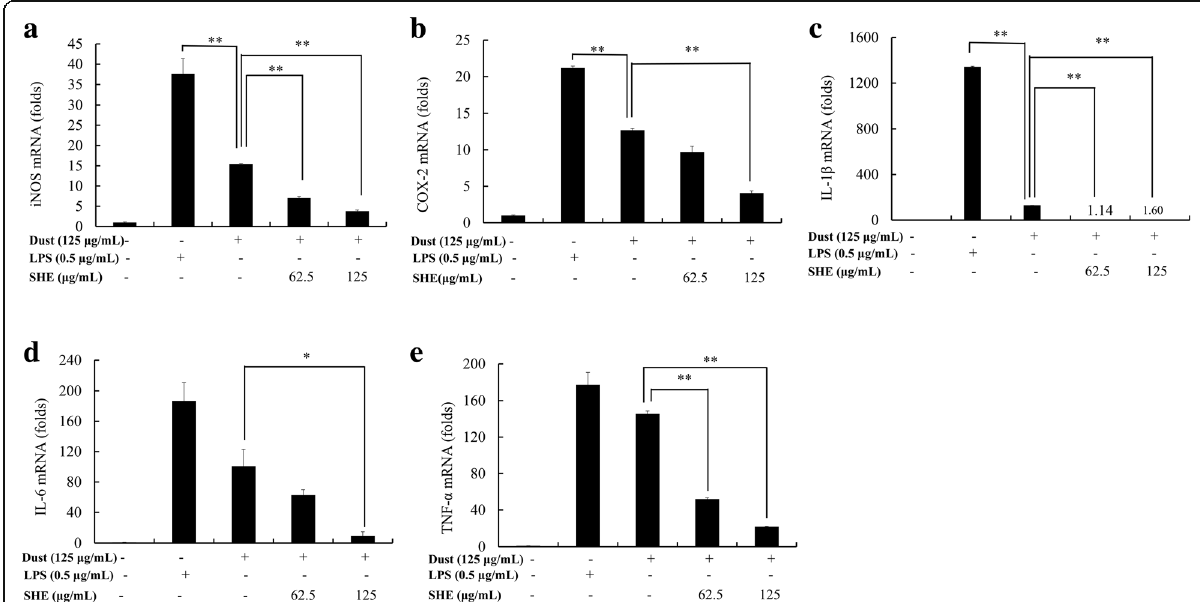
Fig. 4 FD stimulated cells ’ inflammation-associated gene expressions levels: ( a ) iNOS, ( b ) COX-2, ( c ) IL-1 β , ( d ) IL-6, and ( e ) TNF- α . The 2 - ΔΔ Ct method was used to calculate the relative mRNA levels. GAPDH used as an internal reference. Triplicate experiments were performed. mRNA significance relative to the non-treated control was calculated using the Mann-Whitney U test. * = p < 0.05 and ** = p < 0.01